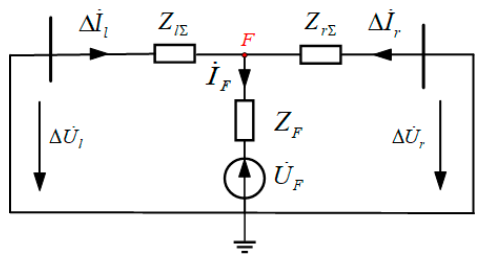
Figure 3. Simplified equivalent circuit model of generator.